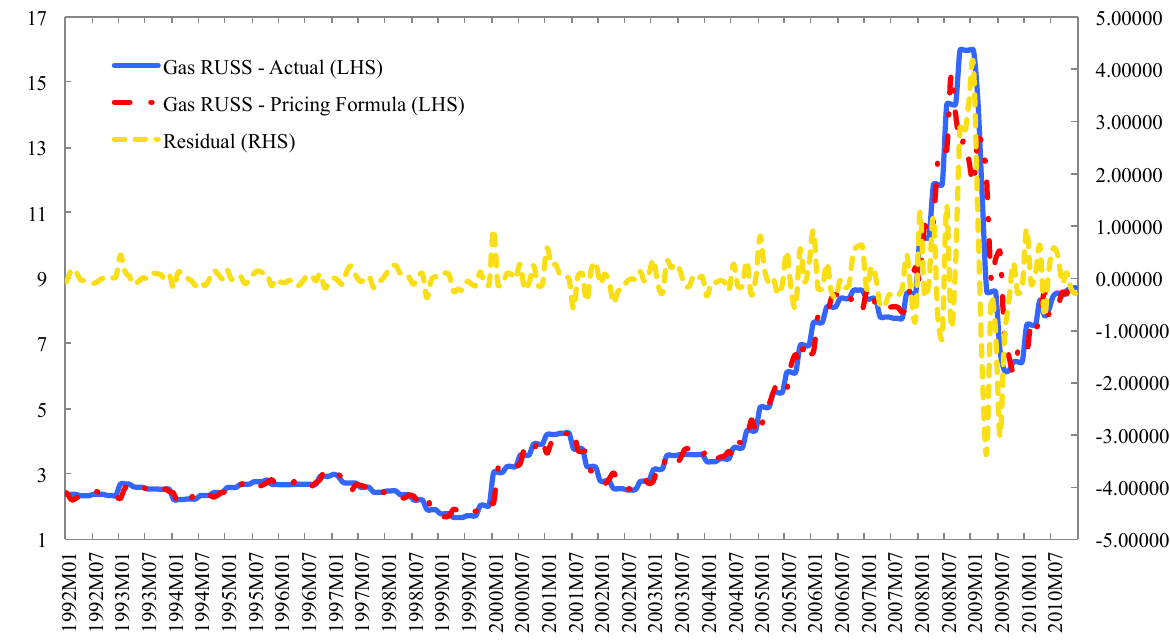
Figure 3. The actual Russian natural gas price and the forecast price by Equation (2). Prices are measured on the left-hand side (LHS) in $/MMBtu and the residuals are measured on the right-hand side (RHS) in